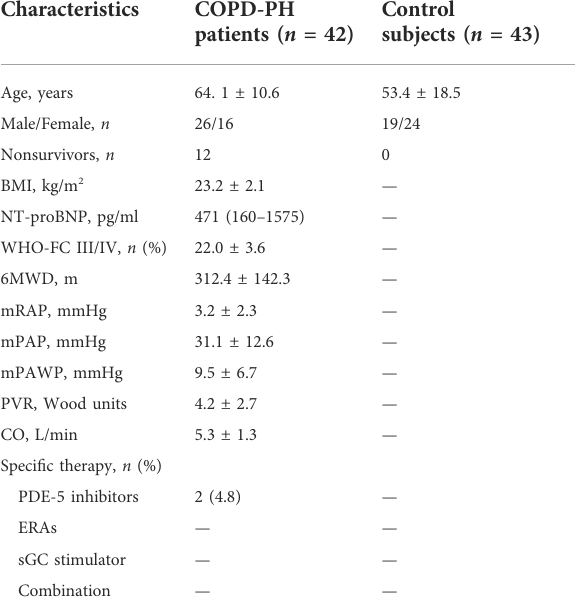
TABLE 1 Baseline characterristics in patients with COPD-PH and healthy controls.